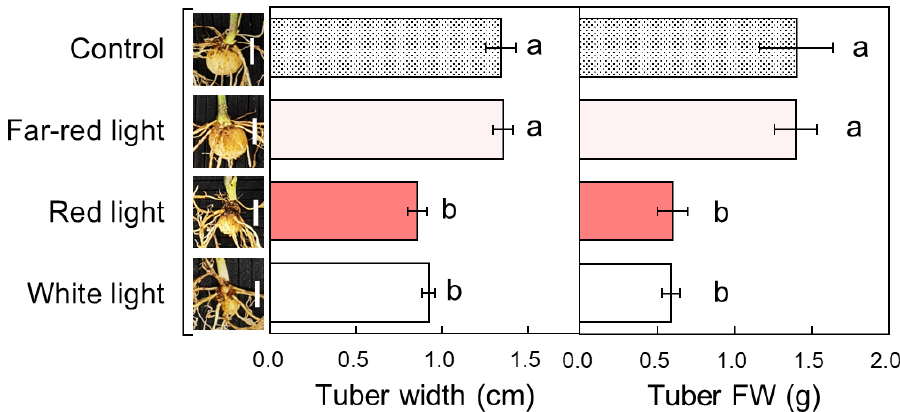
Figure 4. Tuber width and fresh weight (FW) in night-break treatments with different light qualities. Plants were grown for 40 days under a 10 h photoperiod with no (control), far-red, red, or white supplemental lights for 2 h in the middle of the dark period. Values are means ± SD of 7 – 22 replicates derived from different plants. Bars followed by the same letter are not significantly different by Tukey’s test at 5% level. Scale bars, 1 cm.